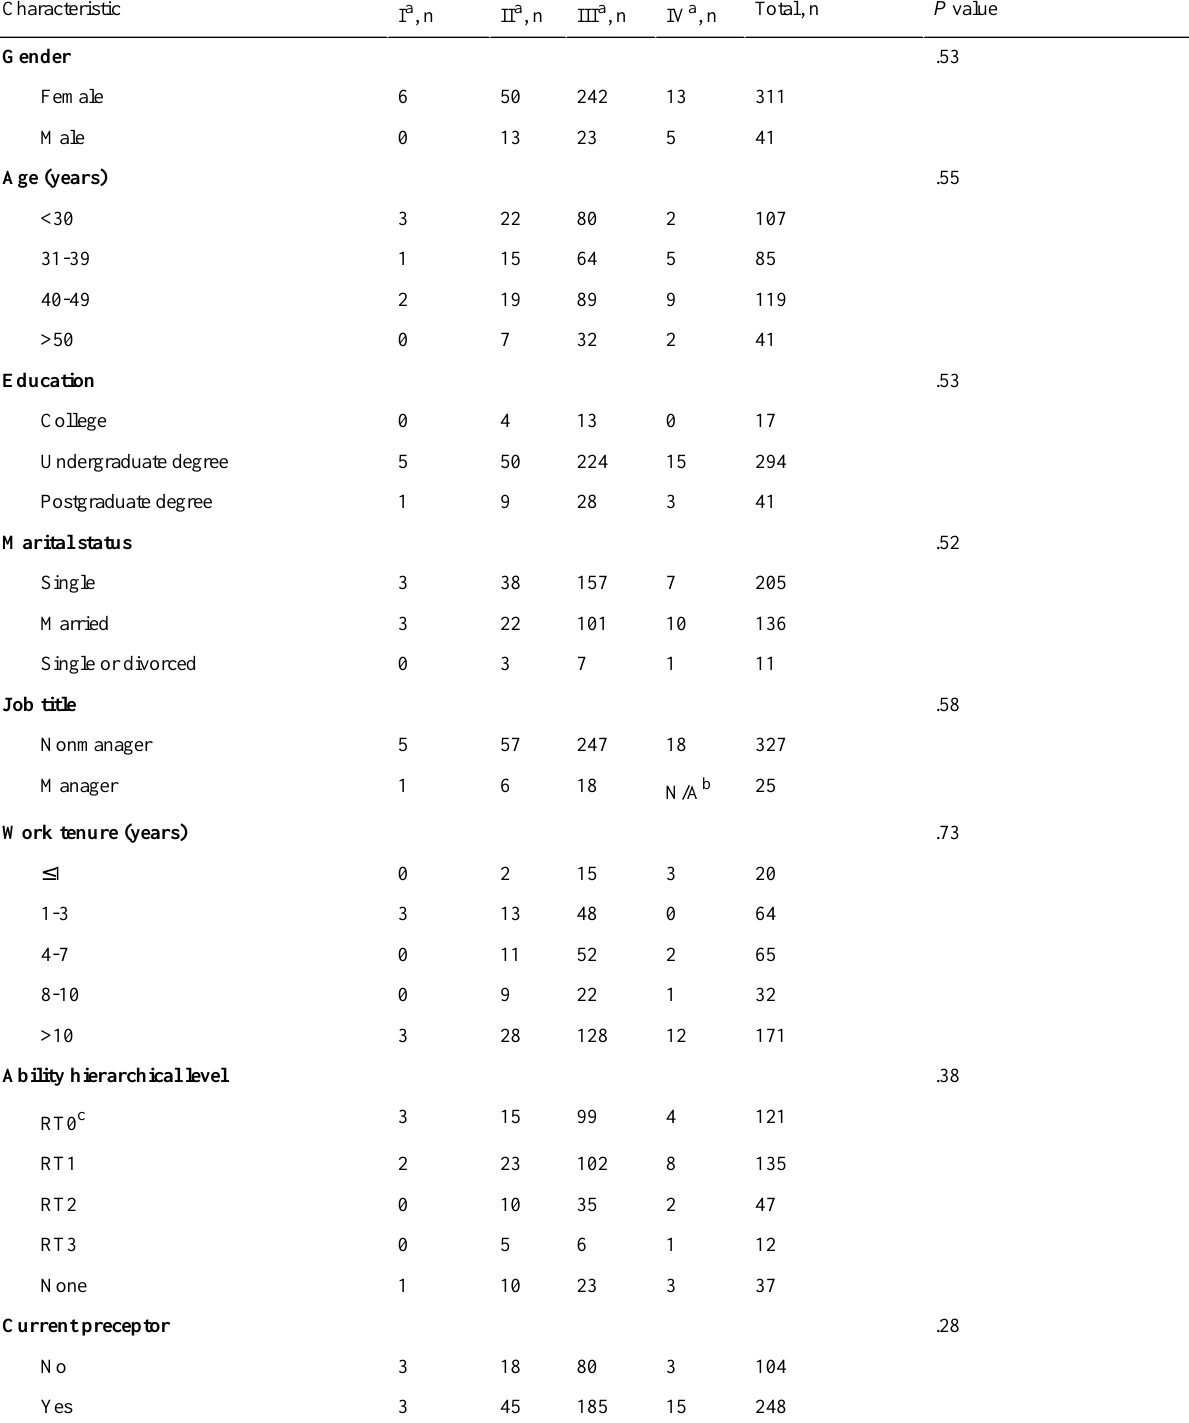
Table 2. Classifications for demographical characteristics